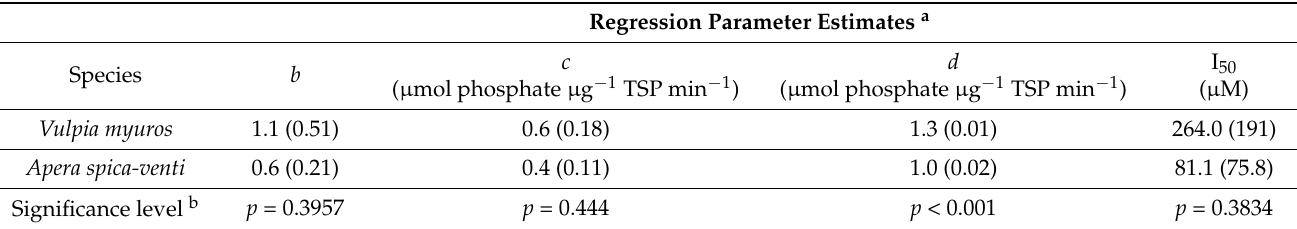
Figure 5. EPSPS activity of Vulpia myuros and Apera spica-venti exposed to different concentrations of glyphosate. Table 3. Parameter estimates of log-logistic equations (1 or 2) applied to determine the sensitivity of EPSPS enzyme activity to glyphosate in leaf extracts of Vulpia myuros and Apera spica-venti . Standard errors are presented in the parenthesis.